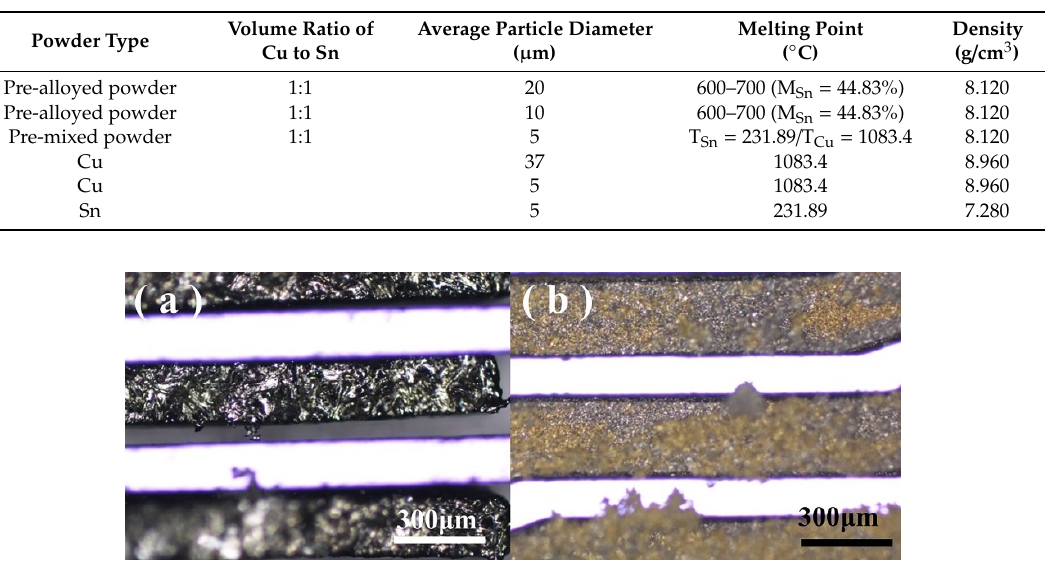
Figure 3. ( a ) After the solidification of tin, significant volume shrinkage occurred, and ( b ) a portion of the tin-rich region also underwent volumetric shrinkage after sintering the pre-mixed powder.